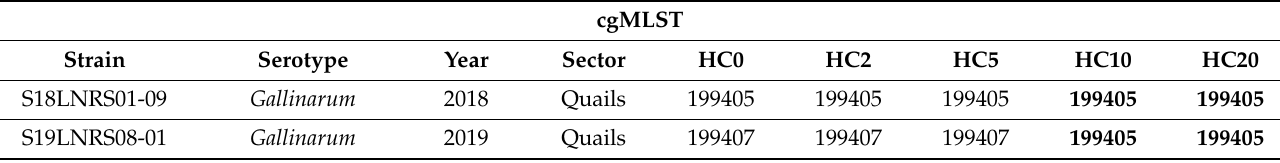
Table 2. Core genome MLST profile of Salmonella Gallinarum strains.